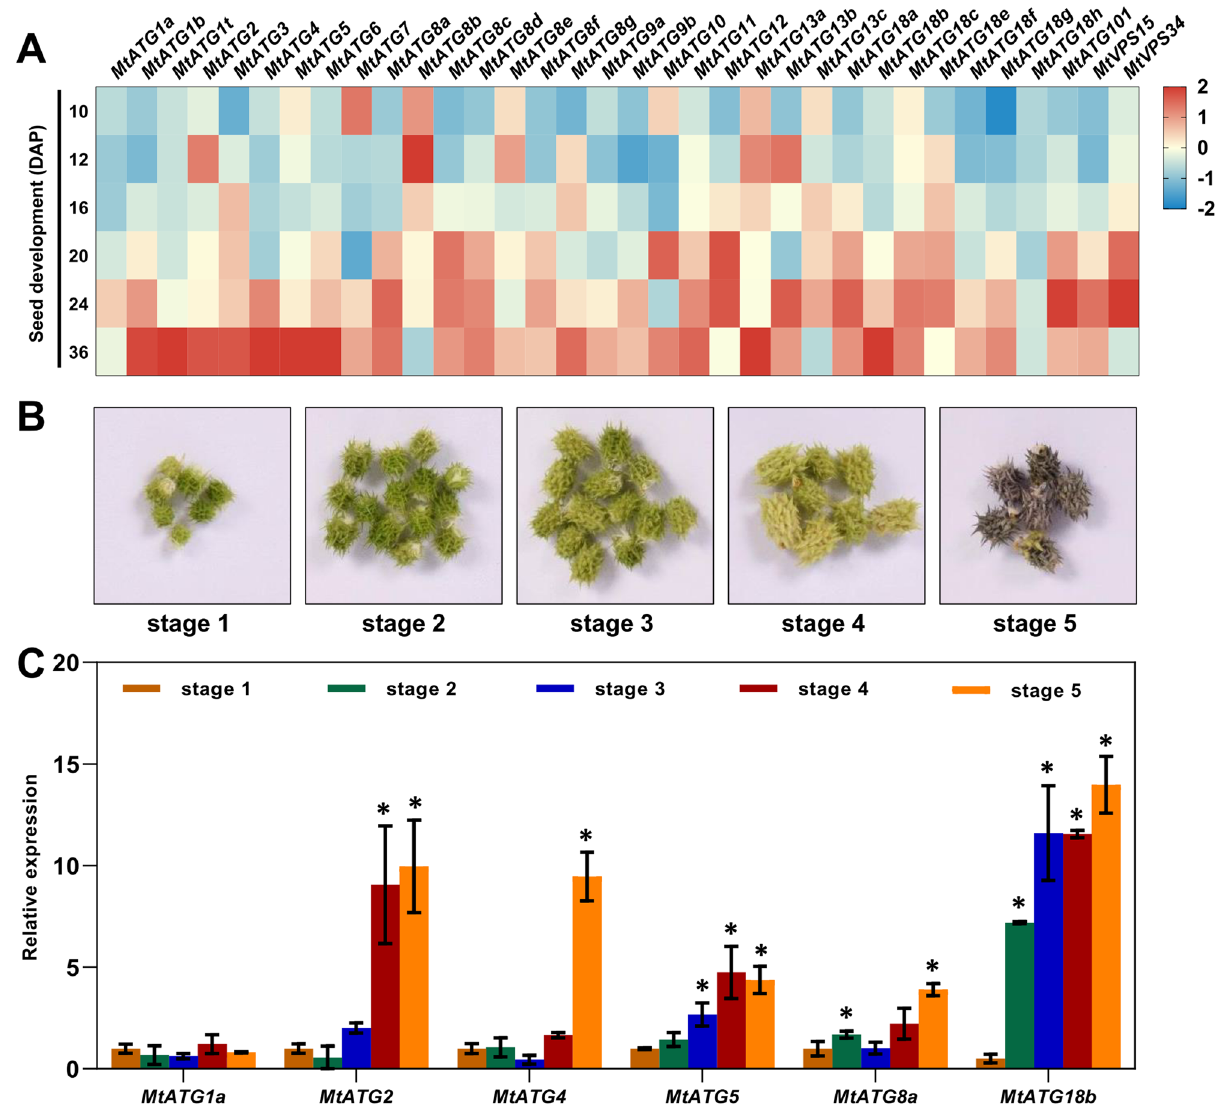
Figure 7. Expression patterns of MtATGs during seed development. ( A ) Gene expression of MtATGs from microarray data during seed development. Seeds were excised form pods at 10, 12, 16, 20, 24, and 36 days after pollination (DAP). Scale bar represents the relative expression value after z-score normalization. ( B ) Different stages of seed development stages in M. truncatula . ( C ) qRT-PCR validation of MtATGs expression during seed development. MtACTIN was used as a reference gene. Error bars represent SD of three independent experiments. Significant differences were indicated with an asterisks (*), P <